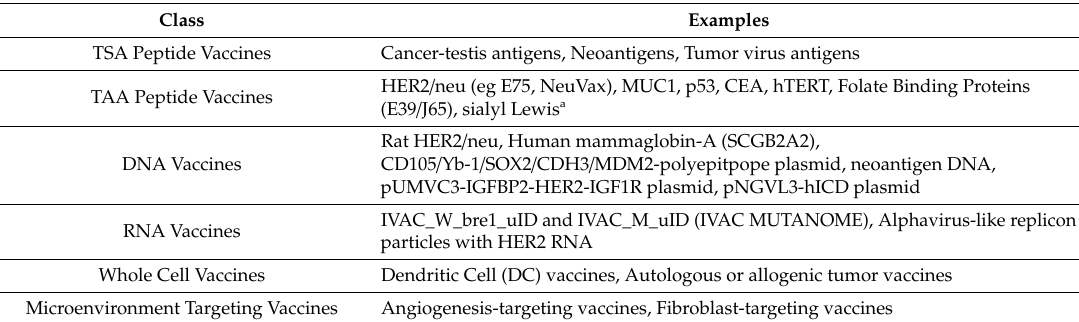
Table 1. BC Vaccine